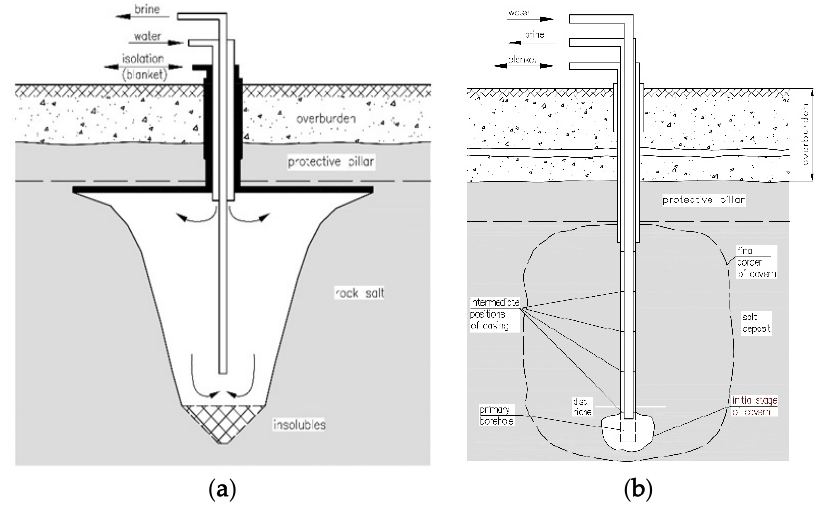
Figure 1. Salt caverns: (a) reverse leaching; (b) direct leaching.